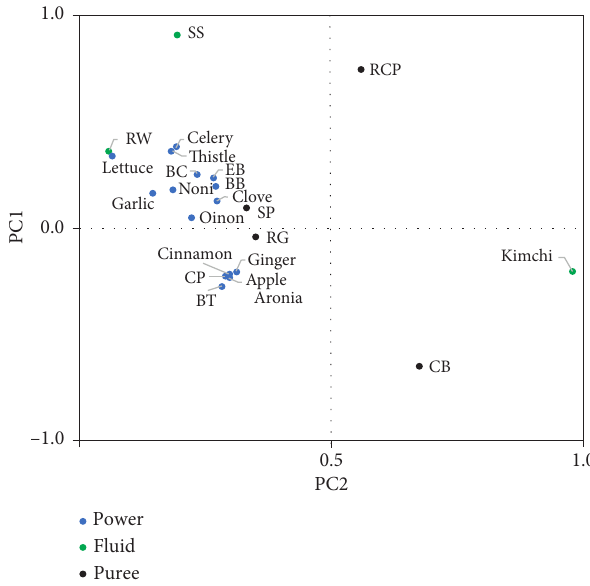
Figure 3: Principal component analysis (PCA) plot. PCA loadings plot for different variables on the two first principal components (PC1 and PC2). SS, soy sauce; RW, red wine; RCP, red chili paste; SP, soybean paste; RG, red ginseng; BC, blackcurrant; EB, elder- berries; CP, chili pepper; BB, blueberries; CB, cherry berry; BT, black